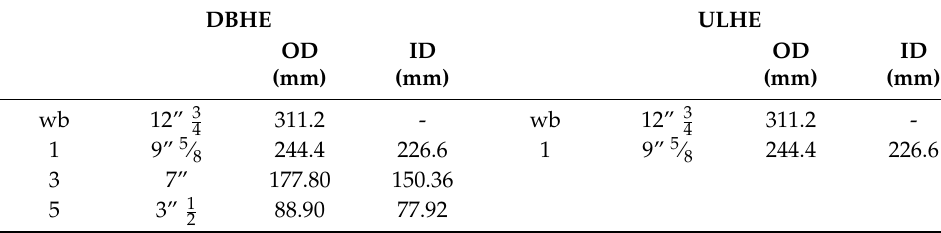
Table 1. Geometrical description of the CLG system configurations.